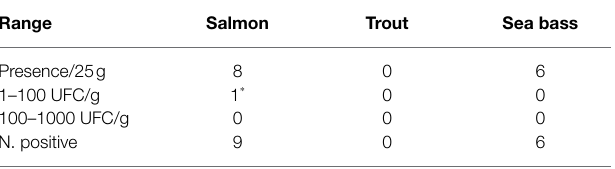
TABLE 2 | Concentration of L. monocytogenes in cold-smoked fish. Range Salmon Trout